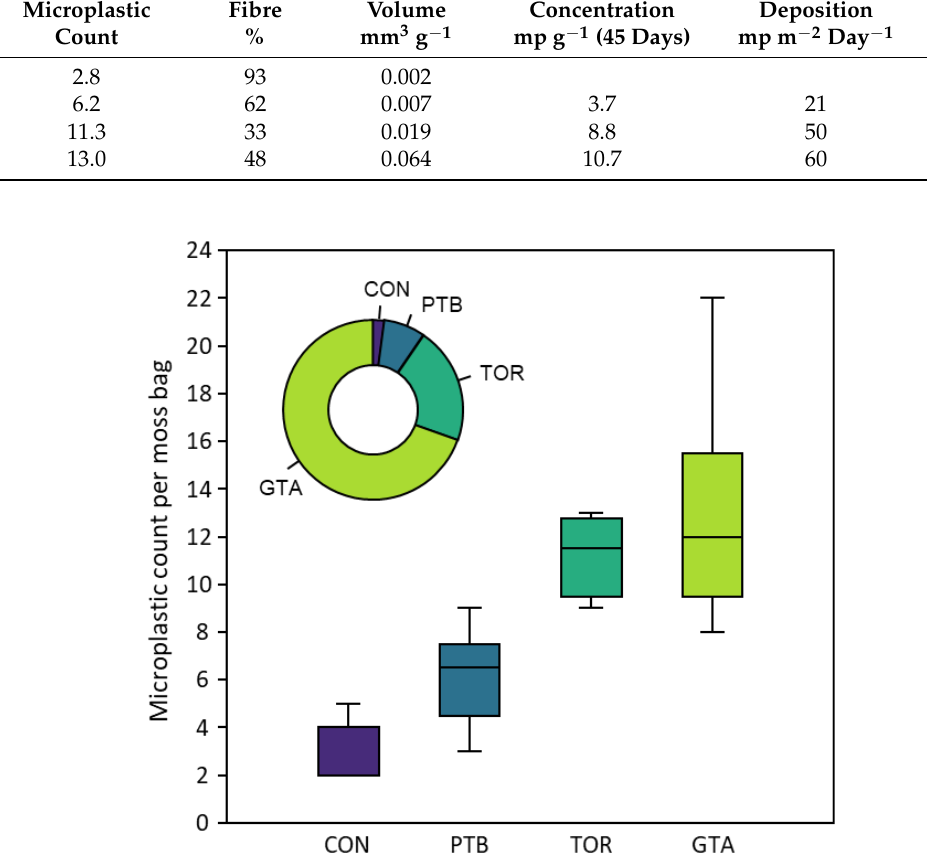
Figure 2. Boxplot showing microplastic count per moss bag within the three urban intensity groups (PTB, TOR, and GTA) and the unexposed control (CON) during the deployment period (45 days, 9 October–23 November 2020). The inset doughnut chart shows the mean microplastic volume per moss bag across the four groups (see Table 3). The median microplastic length was 0.56 mm (range 0.03–4.51 mm) across all Table 3. Mean microplastic count, percent fibre, mean microplastic volume in the unexposed control (CON) bags and three urban intensity groups (PTB, TOR, and GTA), and accumulated concentration (mp g −1 ) in moss bags (dry weight) during the deployment period (45 days; 9 October – 23 November 2020). Estimated daily deposition of microplastics (mp) and plastic microfibres (mf) are also shown.